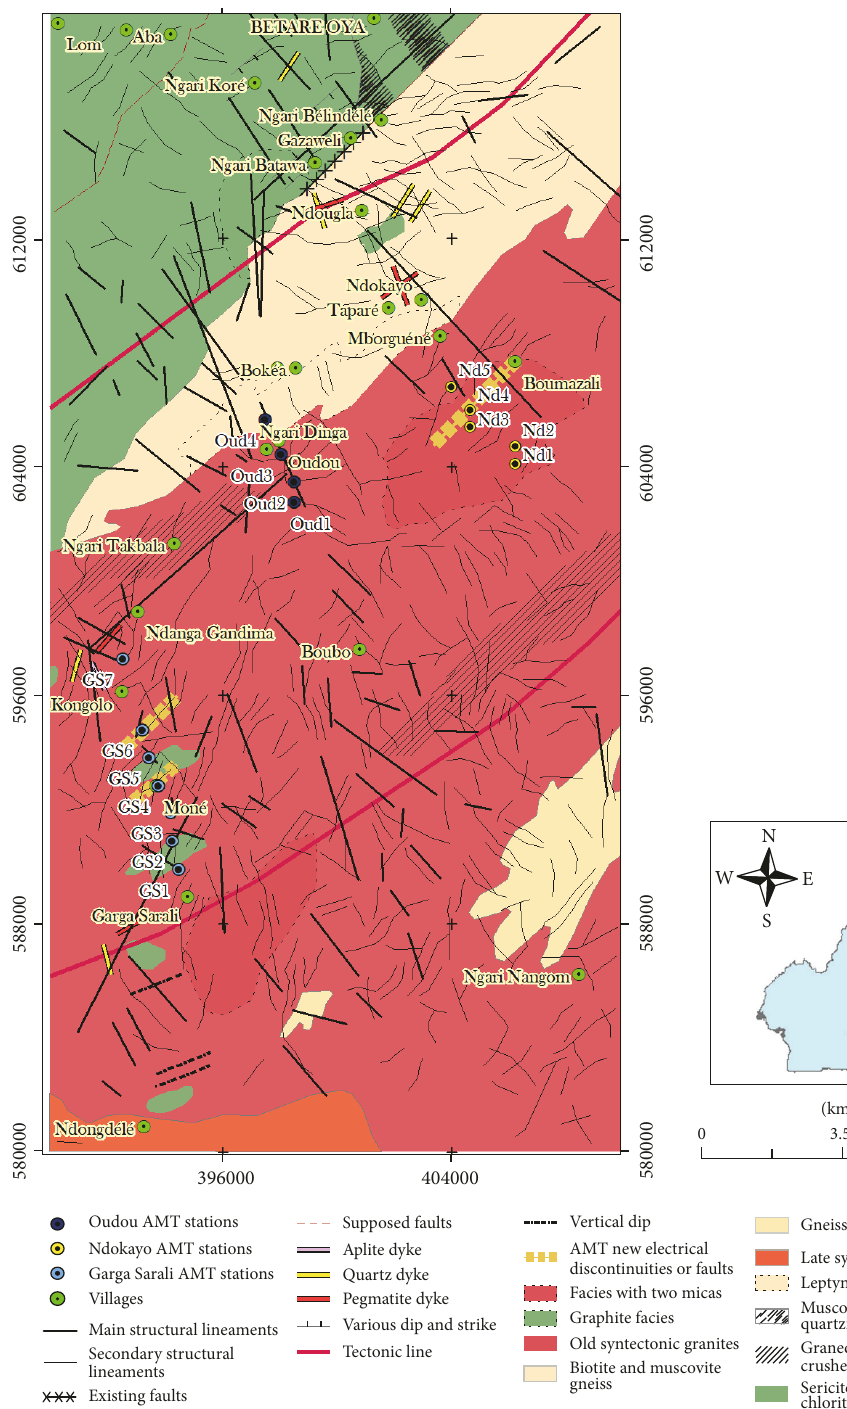
Figure 16: Correlation between surface structural lineaments and the new AMT electrical discontinuities (faults).